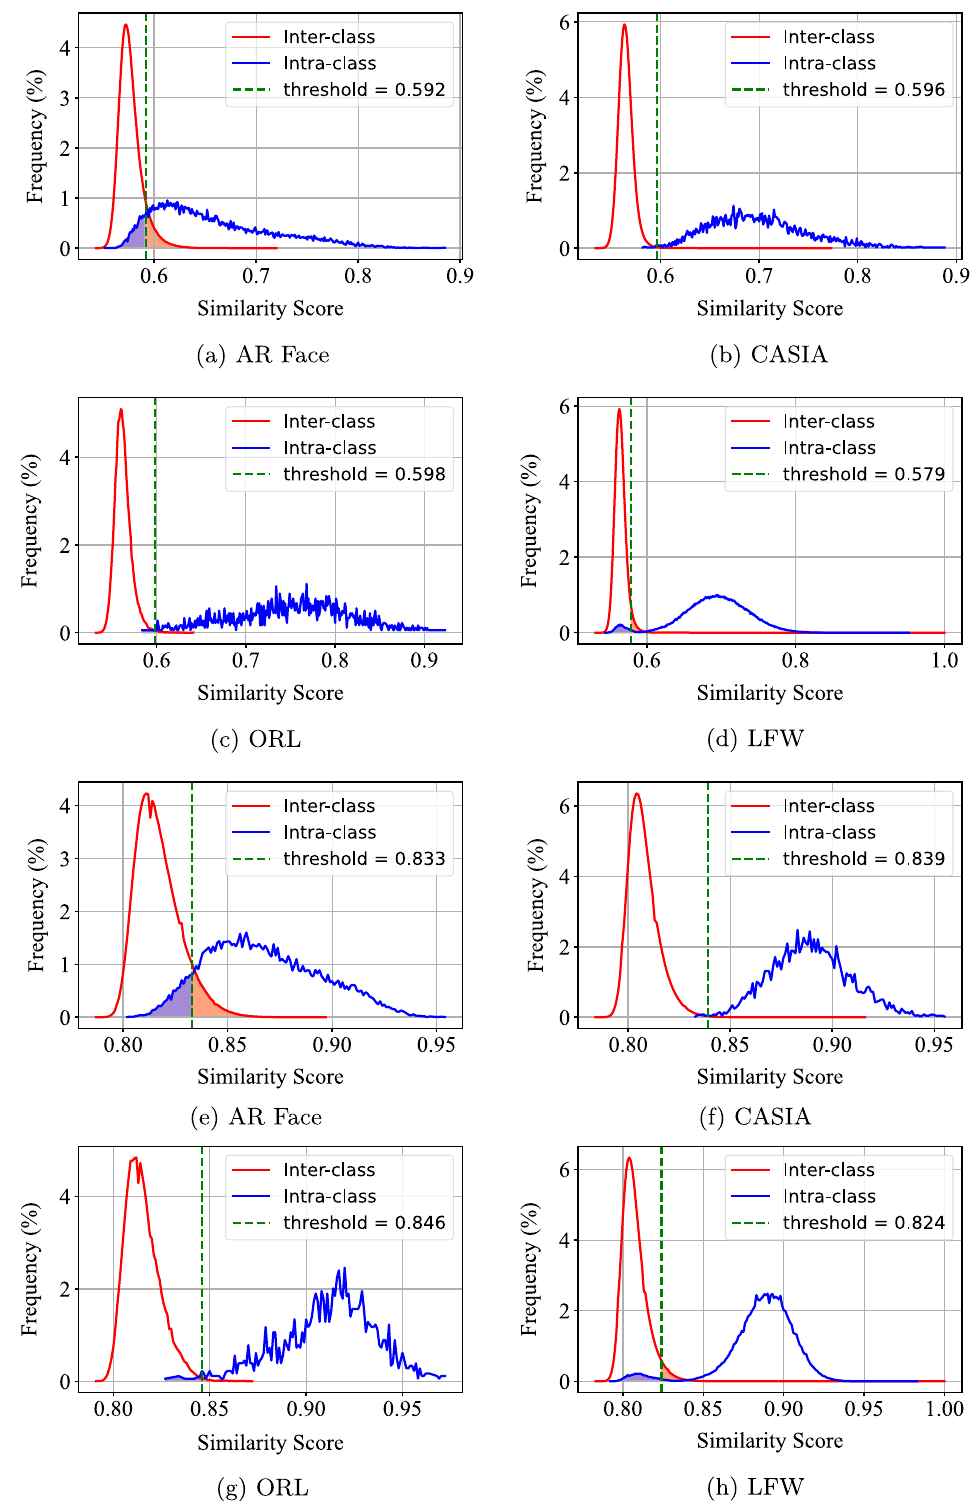
Fig. 4 Threshold of schemes with Euclidean LSH under k = 5000 , n = 2 , c = 1.0 and Cosine LSH under k = 10,000 , N = 2 , d = 2 . a – d show the result of Euclidean LSH-based scheme, while e – h show the result of Cosine LSH-based